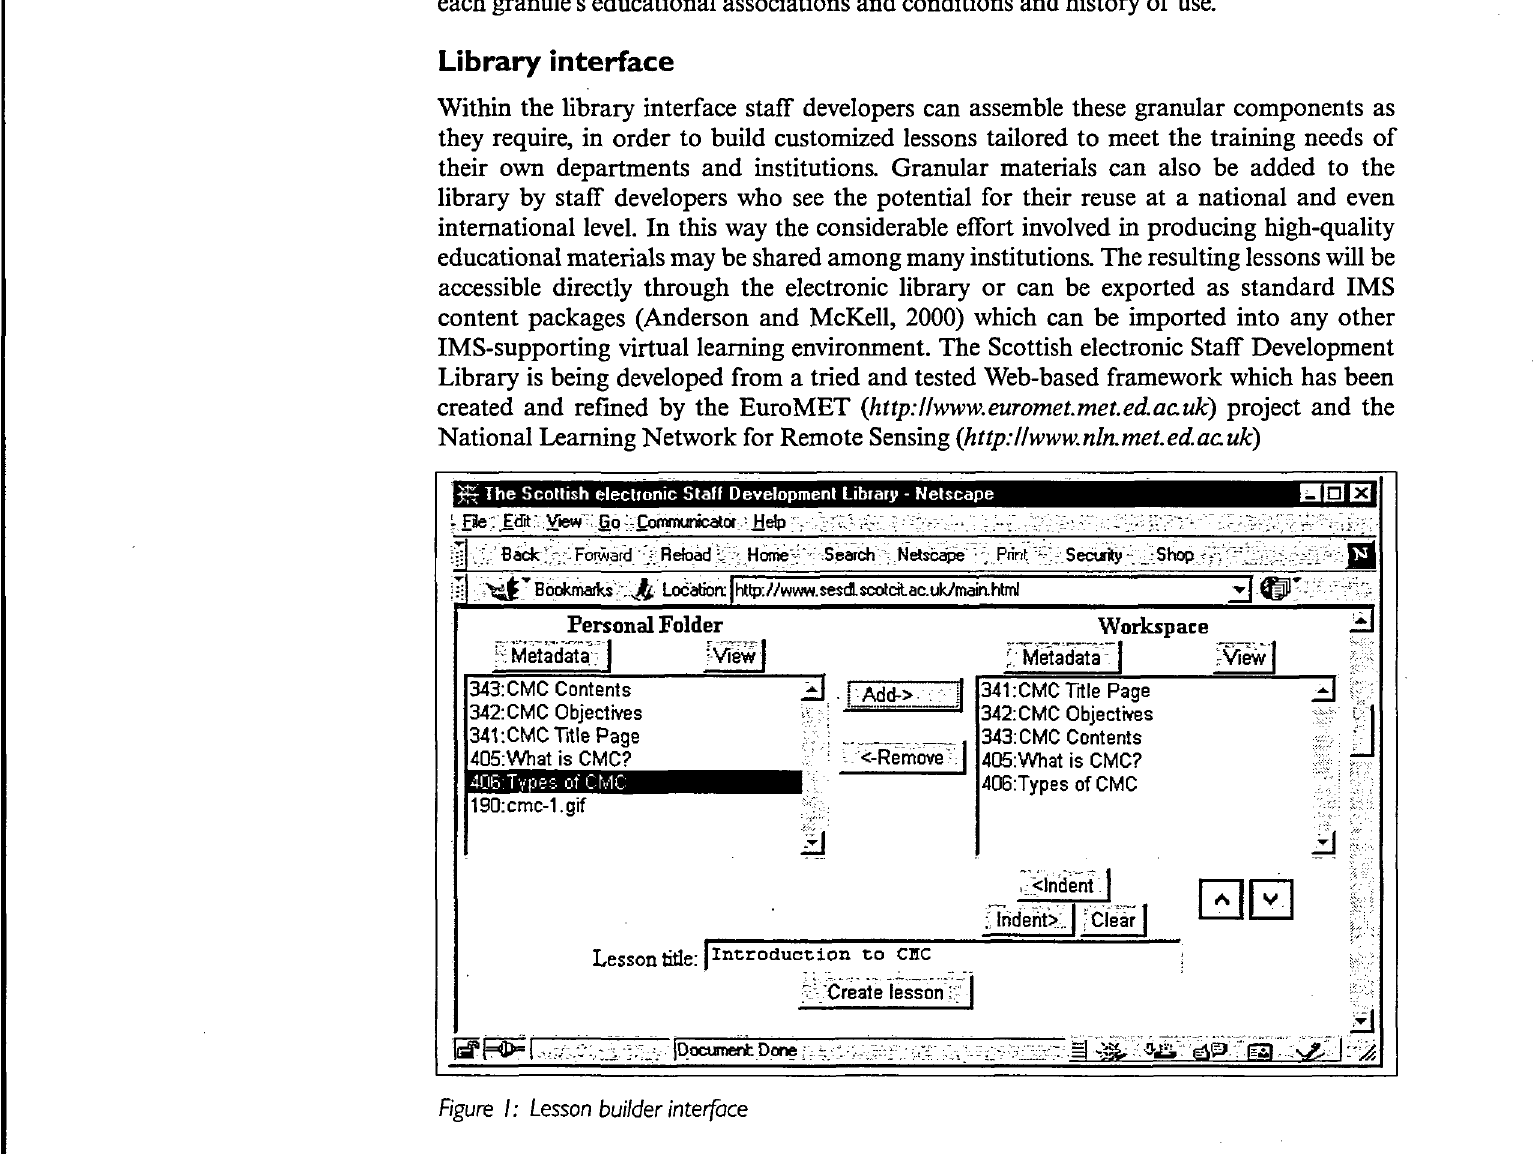
Figure I: Lesson builder